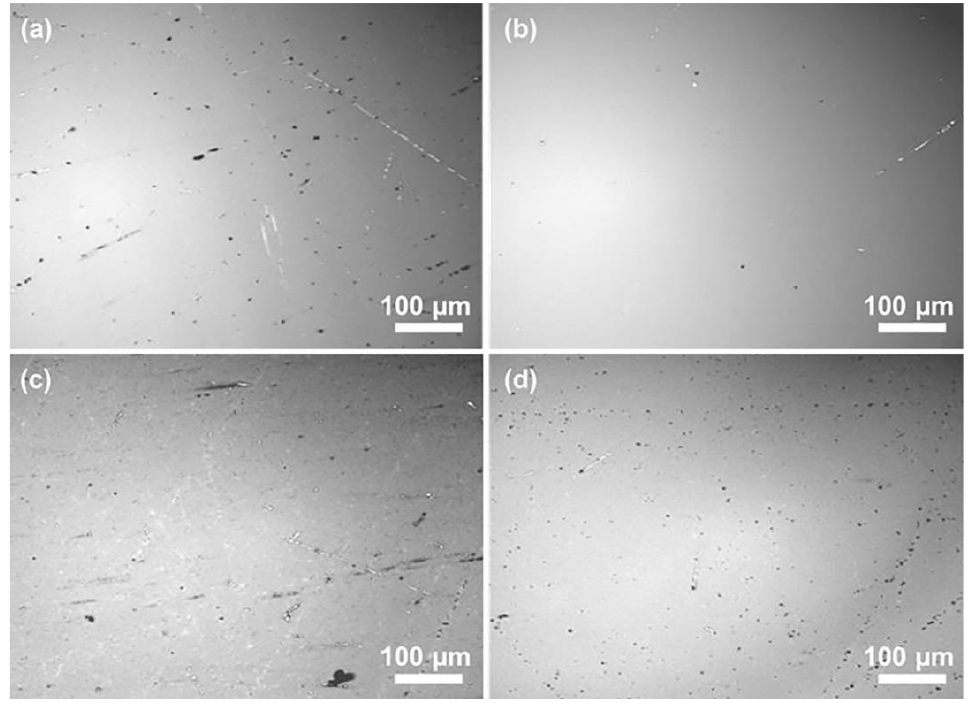
Figure 3. ( a , b ) Surface defects like scratches and pits; ( c , d ) Orange peel defects due to excessive corrosion.